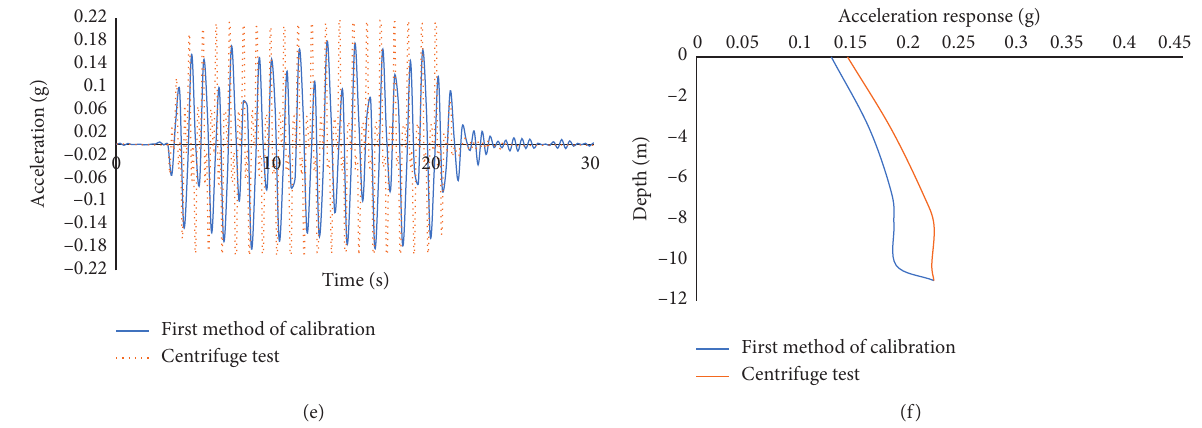
Figure 10: Maximum acceleration response of input motion-3 along the clay: (a) soil surface (numerical results), (b) soil surface (numerical results), (c) soil surface (numerical and centrifuge results), (d) depth � 6.75m, (e) depth � 10.25m, and (f) soil